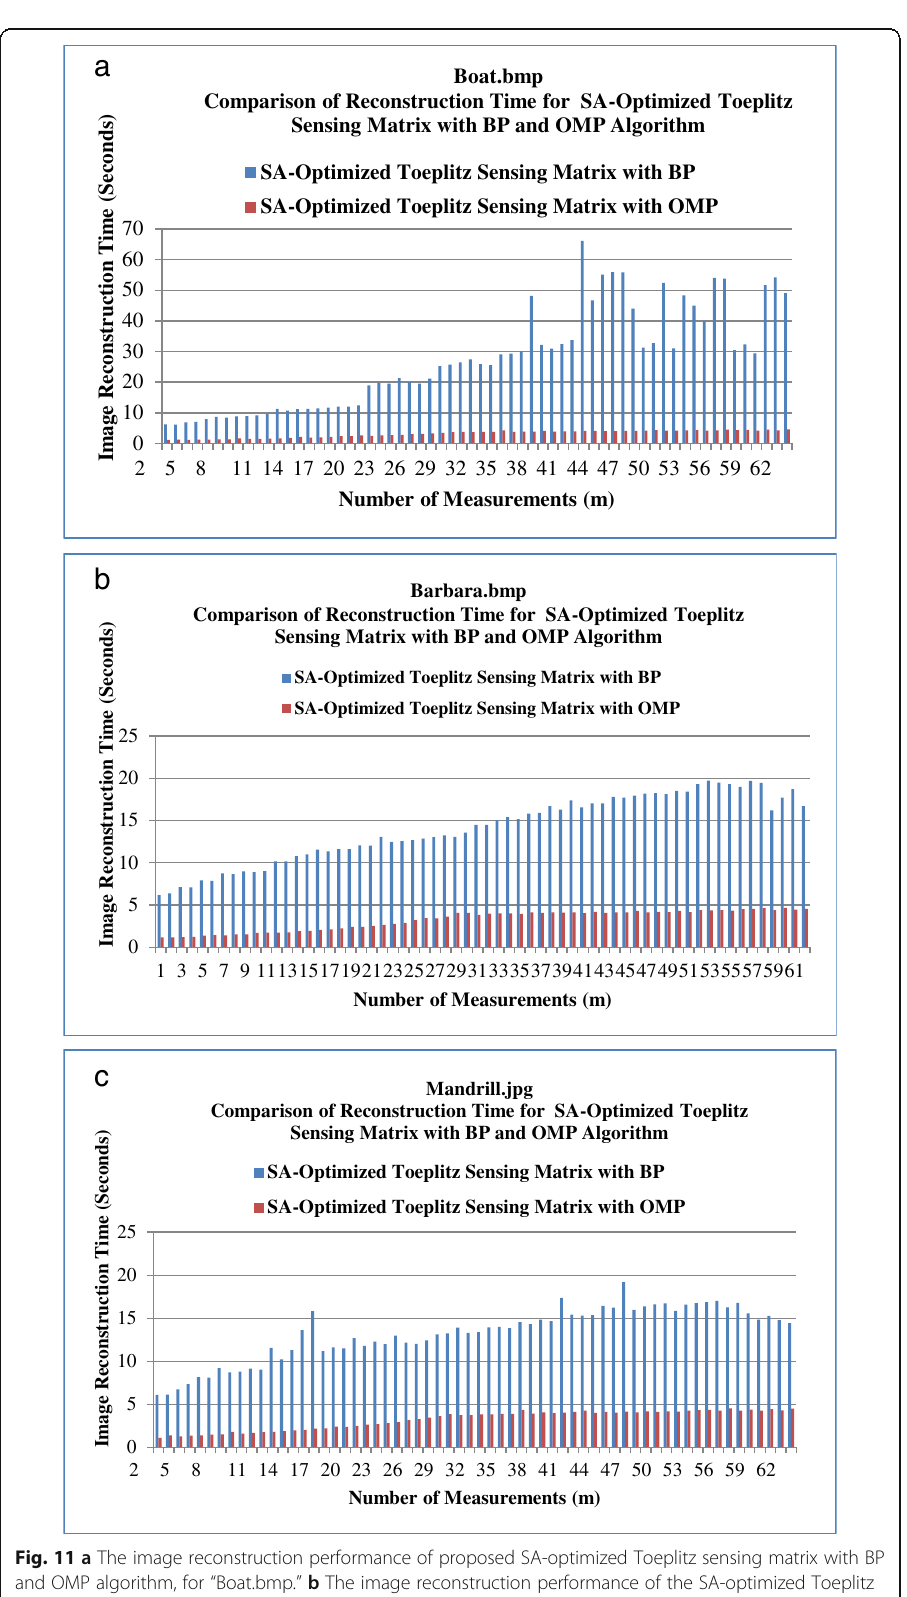
Fig. 11 a The image reconstruction performance of proposed SA-optimized Toeplitz sensing matrix with BP and OMP algorithm, for “ Boat.bmp. ” b The image reconstruction performance of the SA-optimized Toeplitz sensing matrix with BP and OMP algorithm, for “ Barbara.bmp. ” c The image reconstruction performance of SA-optimized Toeplitz sensing matrix with BP and OMP algorithm, for “ Mandrill.jpg